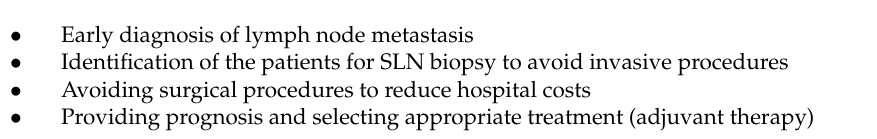
Table 1. Clinical utility of melanoma tissue